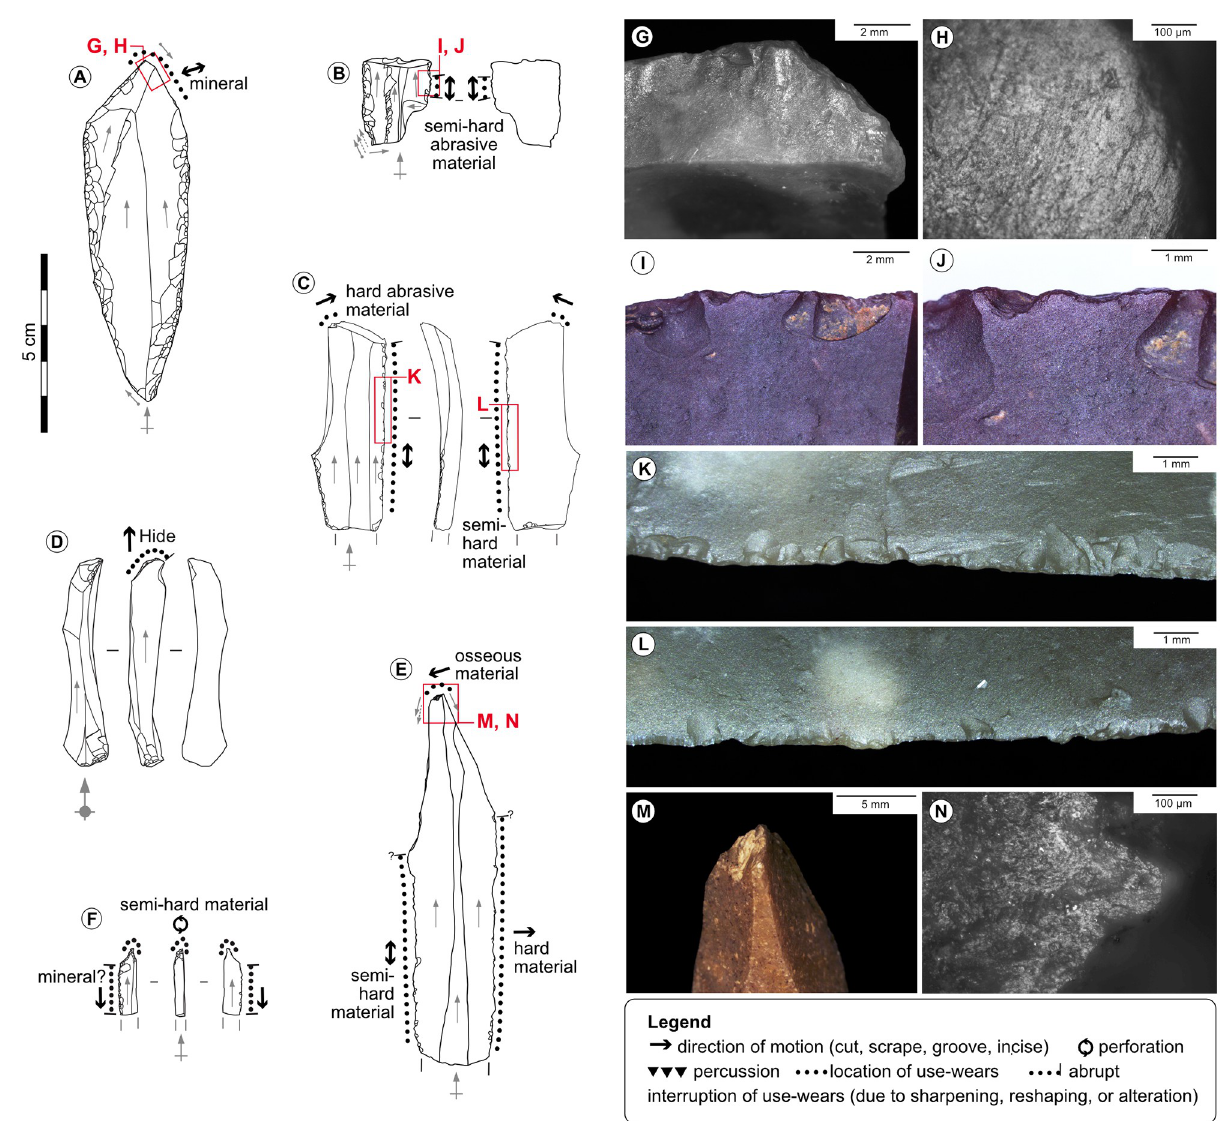
Fig 10. Used burins and spalls. A-Double burin on retouched blade from the Blanchard cave, layer B4. B-Burin on retouched and truncated blade from the Blanchard cave, layer B4. C-Burin on retouched blade from the Blanchard cave, layer B3. D-Large burin spall cutting through a distal endscraper from the Blanchard cave, layer B3. E-Burin on blade from La Marche. F-Microperforator on burin spall from La Marche. G, H-Wears of scraping an abrasive mineral with the distal burin facet of tool n˚A, credits: Gauvrit Roux, 2019. I, J-Rounding of sawing a semi-hard abrasive material, interrupted by direct removals on the lateral edge of tool n˚B. K, L-Scars due to sawing a semi-hard material with the lateral edge of tool n˚C. M, N-Wears of grooving an osseous material with the burin bevel of tool n˚E, credits: Gauvrit Roux, 2019.